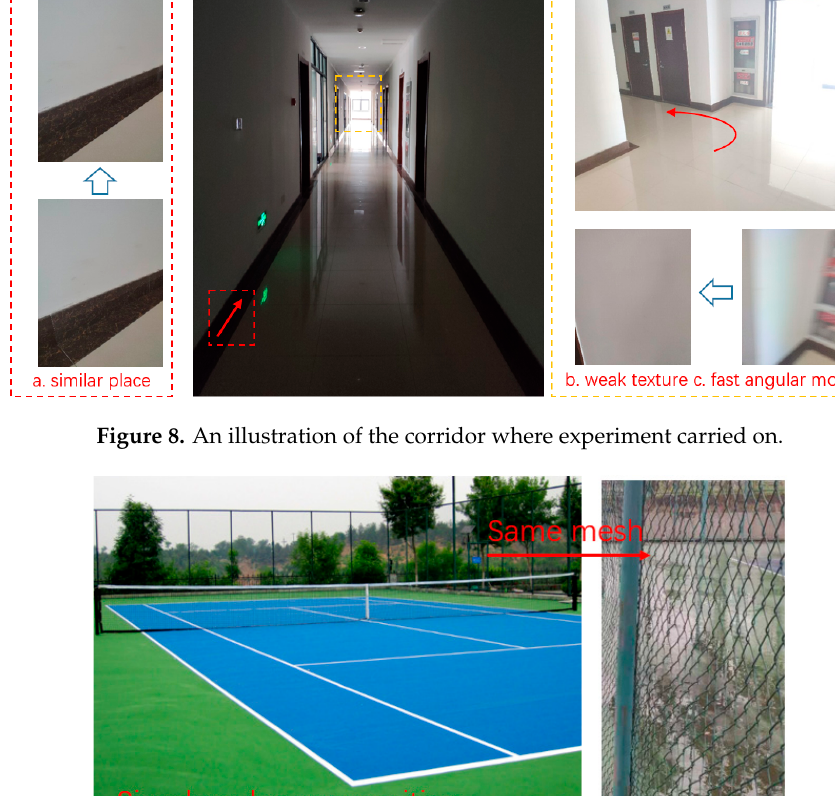
Figure 9. An illustration of the tennis court where experiment carried on.